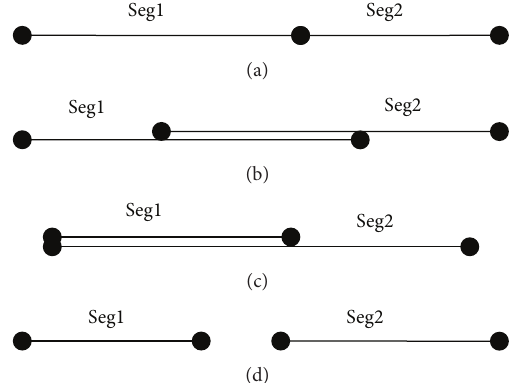
Figure 8: Two segments of a facility in one edge.